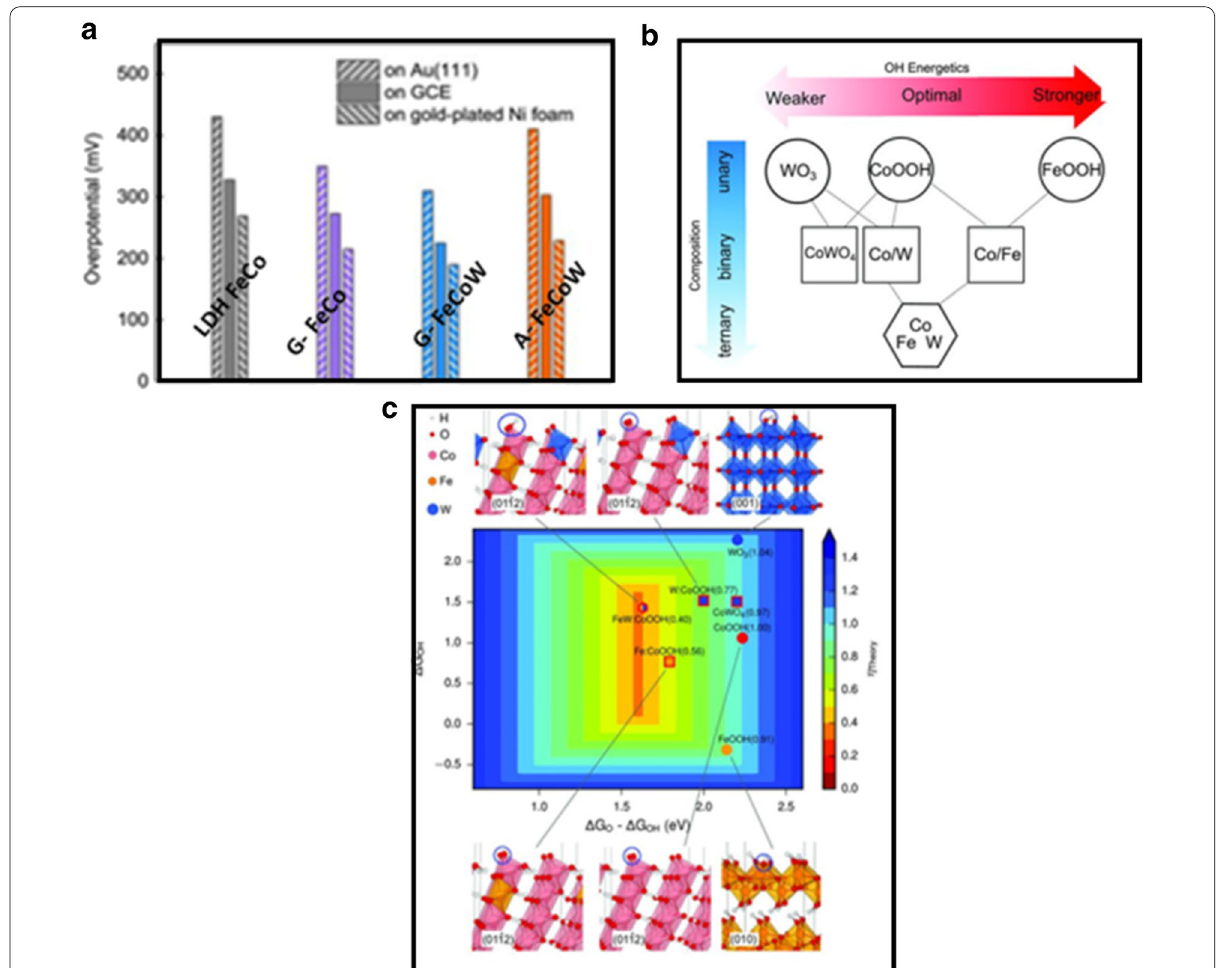
Fig. 14 a Overpotentials obtained from OER polarization curves on Au(111), GCE (glass carbon electrode), and gold‑plated Ni foam at 10 mA cm − 2 . b Illustration of tuning the energetics of OER intermediates on CoOOH via alloying with Fe and W. c Map of OER activities for pure Fe, Co oxyhydroxides and W, Fe‑doped Co oxyhydroxides, cobalt tungstate, and W oxides calculated with DFT Ref.